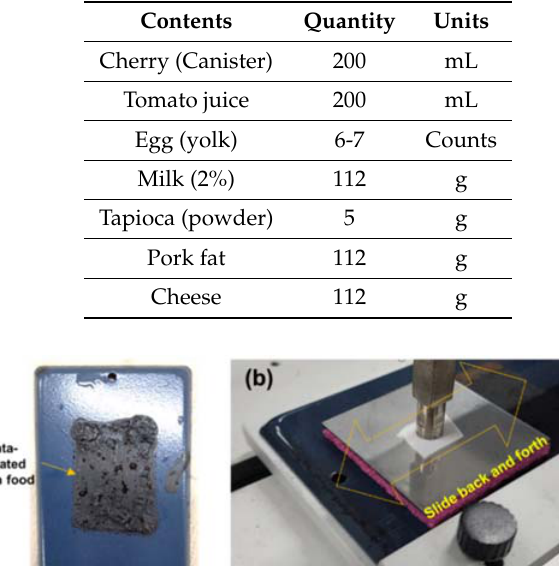
Table 3. List of food and weight used for burnt contamination test.